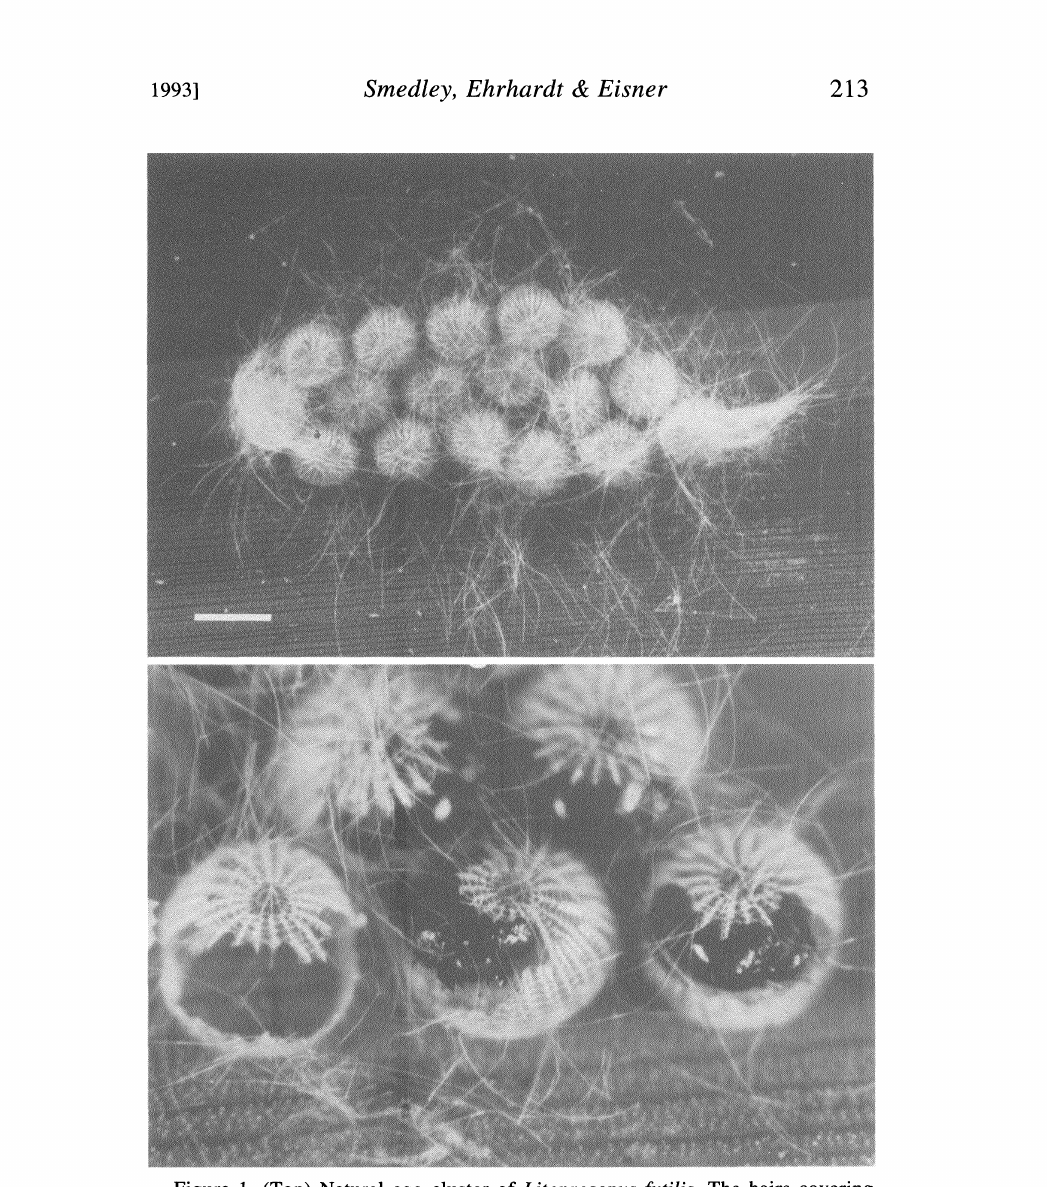
Figure 1. (Top) Natural egg cluster of Litoprosopus futilis. The hairs covering the eggs are presumably detached modified scales from the mother’s body (Bar mm). (Bottom) Eggs in the process of hatching; note mandibles agape on larva in center